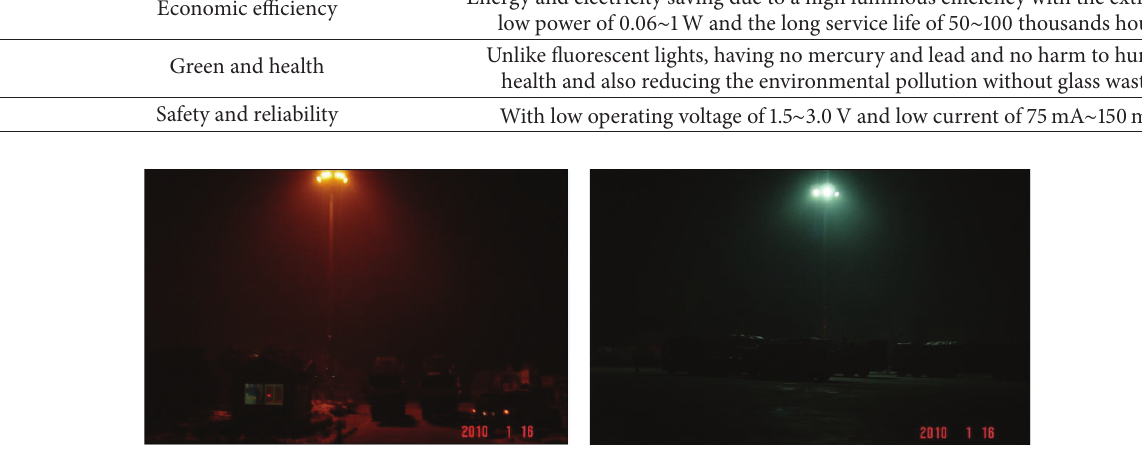
Figure 8: The comparison of lighting effects of high voltage sodium lamp and solar Photovoltaic LED lamps in parking lot.